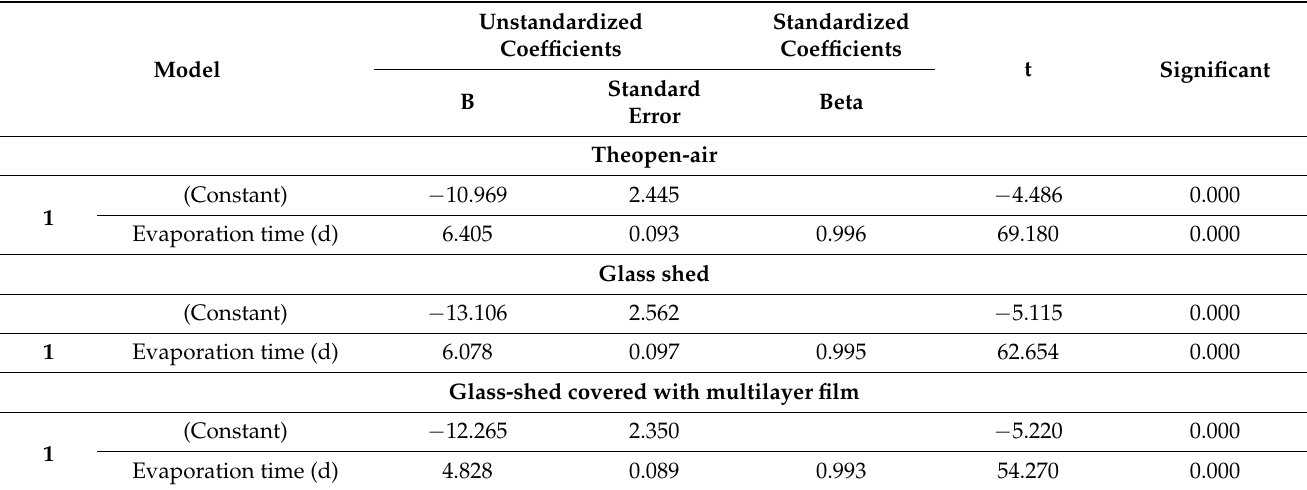
Table 7. The output of the SPSS shows a coefficients a table of the three